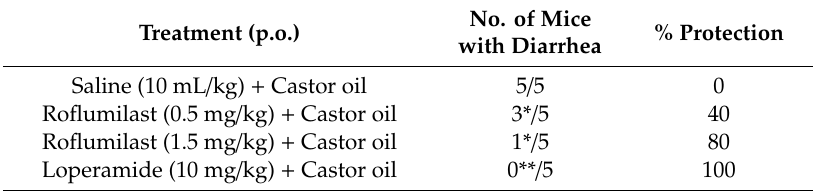
Table 1. Antidiarrheal activity of roflumilast on castor oil (10 mL / kg)-induced diarrhea in mice. Treatment